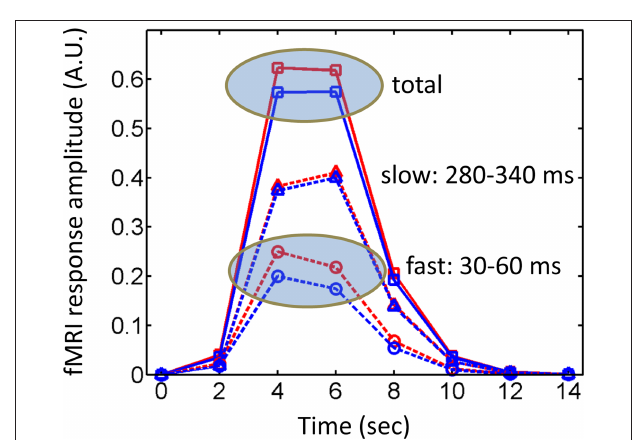
Figure 2 | Simulated fMri responses and timing. During the hard condition in the study by Luo et al. (2010), fast responses varied as a function of valence, whereas later responses did not – i.e., attention affected the latter, but not the former. However, fast responses are not inherently invisible to fMRI, and are expected to generate differential fMRI responses, as suggested by the simulated responses labeled “fast”. The “slow” component was also simulated and no differential responses would be expected (the slight displacement was used for display only). A typical fMRI study would pick up the “total” signal containing the contributions of both fast and slow components and, in theory, should be sensitive to the differences that were present only in the first time window (see also Figure 1 ). Simulated responses were generated by convolving an initial input function with a canonical hemodynamic response (Cohen, 1997). The input function can be viewed as a boxcar with “fast events” occurring between 30–60 ms and “slow events” occurring between 280–340 ms (a virtual temporal resolution of 10 ms was used in the definition of the boxcar events and in the convolution operation). The “fast” effect of emotional content was simulated by assuming a boxcar of intensity 0.2 versus 0.25 for affective and neutral conditions, respectively. Finally, it was assumed that fMRI signals were sampled every 2 s. Red lines: affective conditions; blue lines: neutral conditions; dashed lines: fast and slow components; solid lines: total signal; A.U.: arbitrary